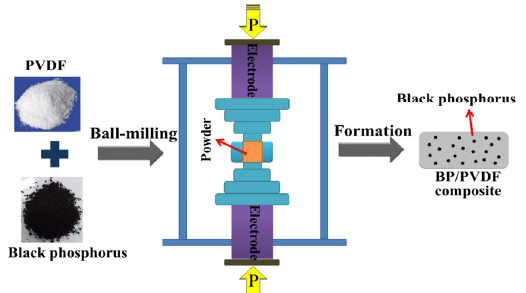
Fig. 30 Schematic diagram of preparation process of BP/PVDF composites.